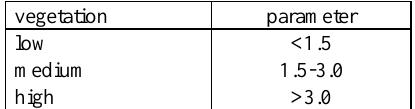
Table 2. ALS point cloud classification parameters